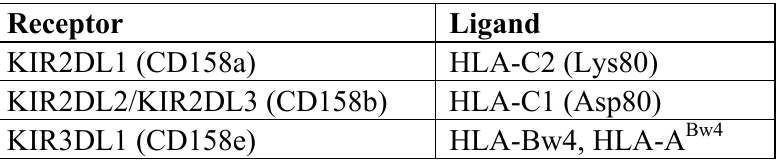
Table 2. KIR/KIR-L Match-Mismatch algorithm.